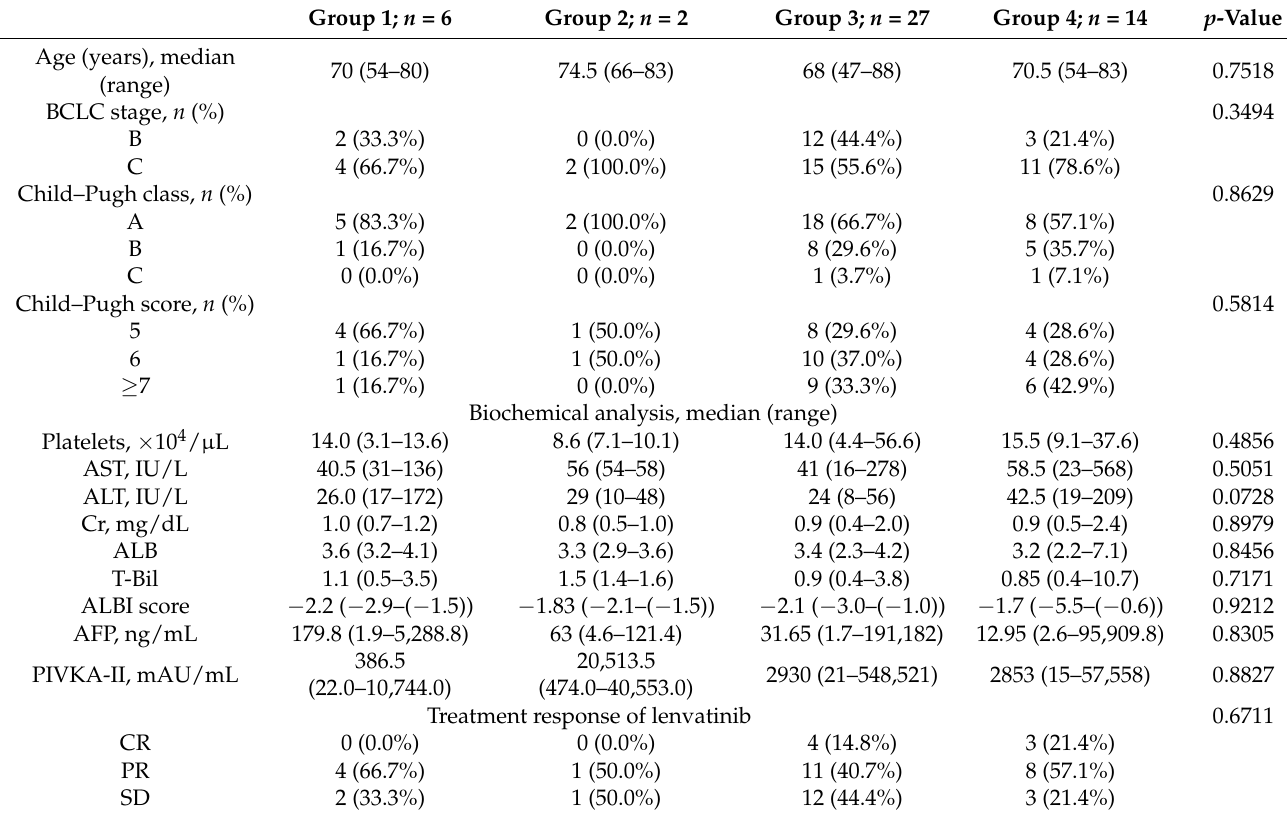
Table 3. Comparison of patient characteristics at progressive disease point among the four groups clas- sified according to changes in growth factors between best response and progressive disease